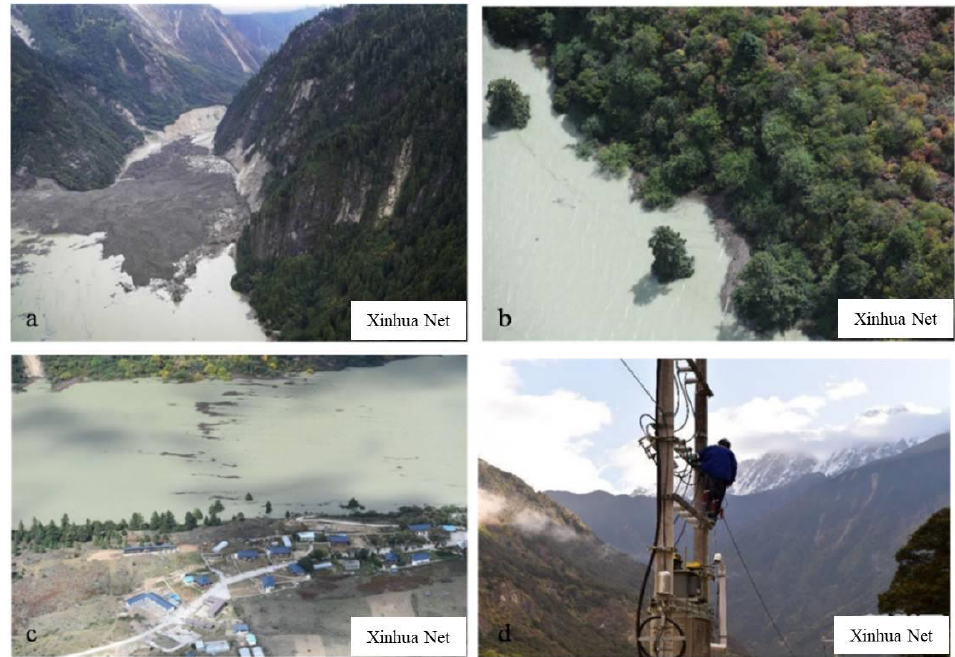
Figure 2. Photographs of the conditions following glacial debris flow event: ( a ) the dammed lake and the barrier body; ( b ) the rising water level of the barrier lake; ( c ) flooding in the Jala village; ( d ) the electric power department cut the power to prevent accidents. The Chinese blue writing means the source of the photographs is from Xinhua Net (http://www.xinhuanet.com/photo/2018-10/18/c_129974593.htm, accessed on 10 March 2019).